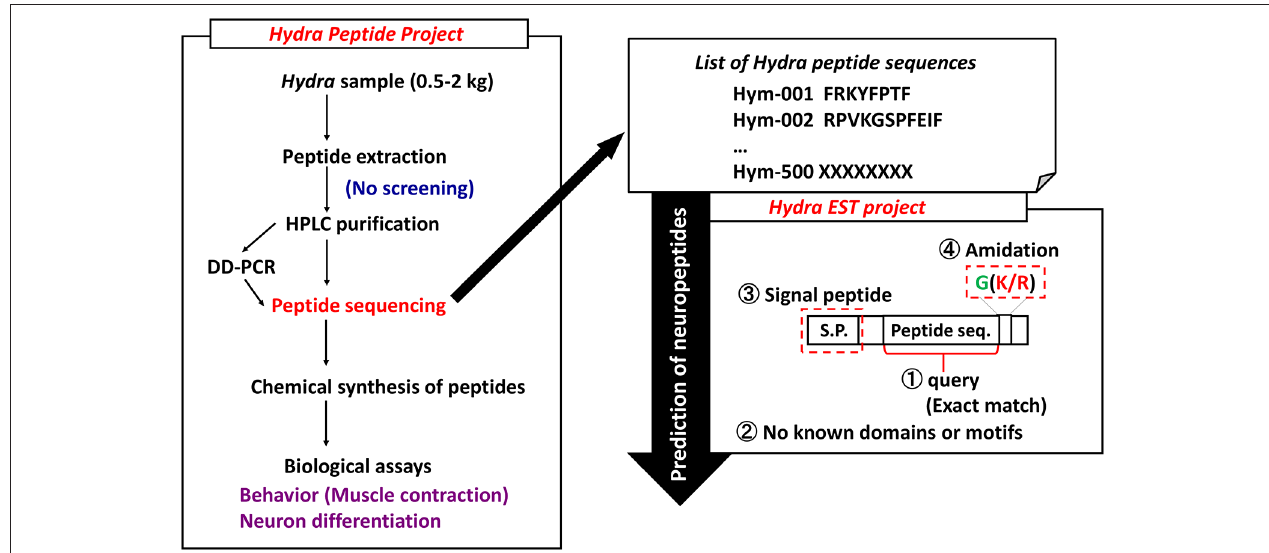
FIGURE 1 | Strategy to identify Hydra neuropeptides. DD-PCR, differential display PCR; HPLC, high performance liquid